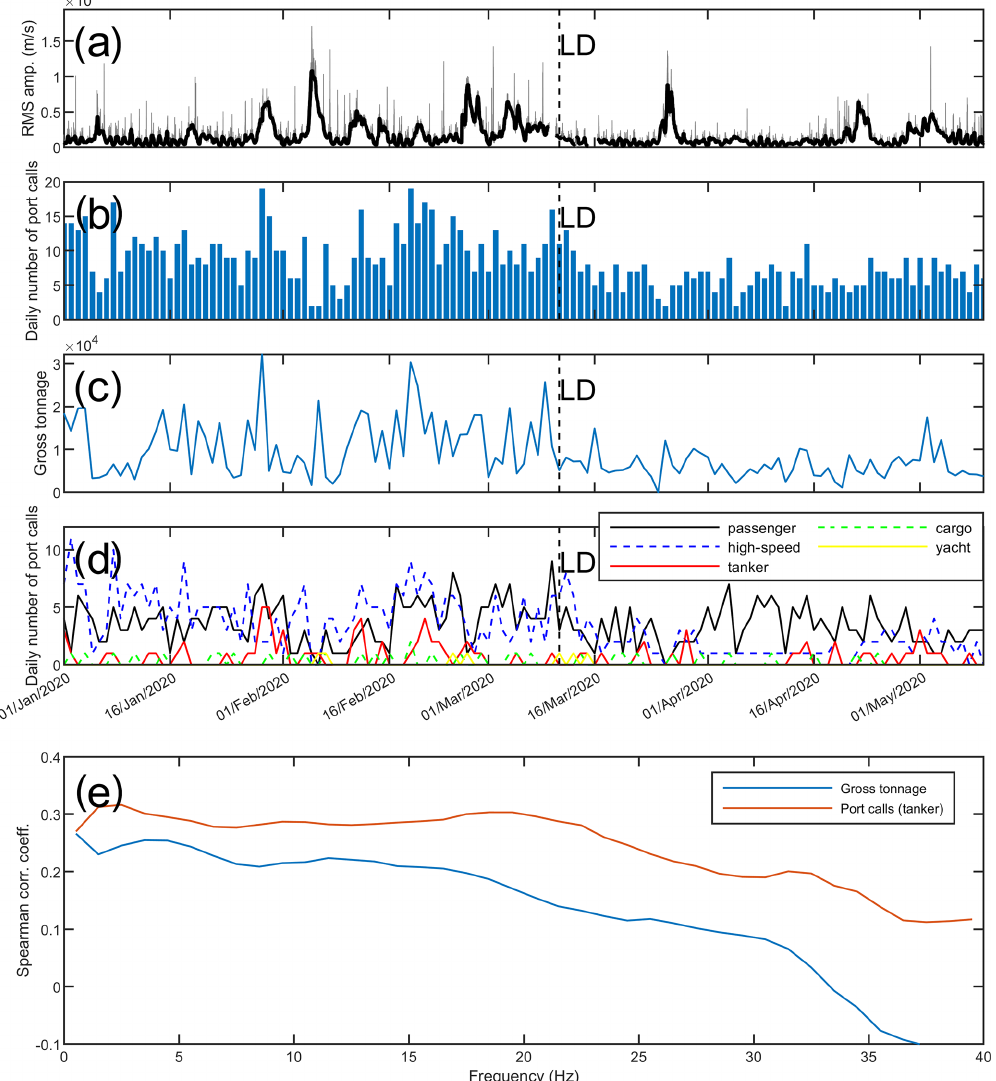
Figure 11. (a) Rms amplitude time series of the vertical component of the seismic signal, recorded by ILLI station and filtered in the band 10–40Hz (grey line) and corresponding moving median computed on 1d long sliding windows (thick black line). (b) Daily number of port calls in the Lipari port. (c) Daily overall gross tonnage in Lipari port. (d) Daily number of port calls in Lipari port, separated on the basis of the boat category. (e) Spearman correlation coefficient, calculated between seismic rms amplitude at ILLI and two ship traffic parameters (see the legend in the upper right corner), as a function of the frequency band of the seismic noise. The vertical dashed line and the label “LD” in (a) – (d) indicate the time when the national lockdown measures were implemented in Italy (11 March 2020).